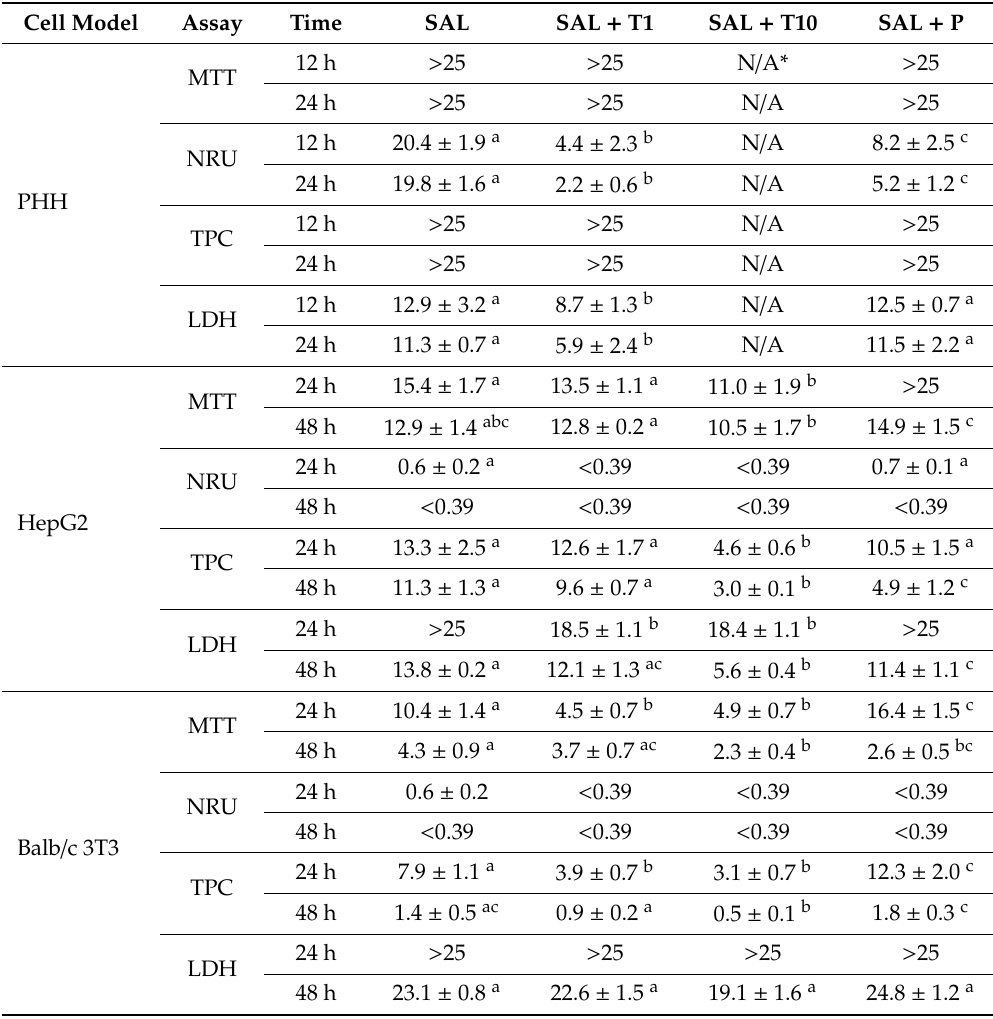
Table 1. The e ff ective concentrations (EC 50, µ g / mL) determined in primary human hepatocytes (PHH), HepG2 and Balb / c 3T3 cells by MTT, NRU, TPC, and LDH assays after 12, 24, and 48 h exposure to salinomycin (SAL) and its combination with tiamulin at concentrations 1 µ g / mL (SAL + T1) and 10 µ g / mL (SAL + T10) or prednisolone at concentration 1 µ g / mL (SAL + P). Data are presented as mean ± SEM ( n = 3, independent